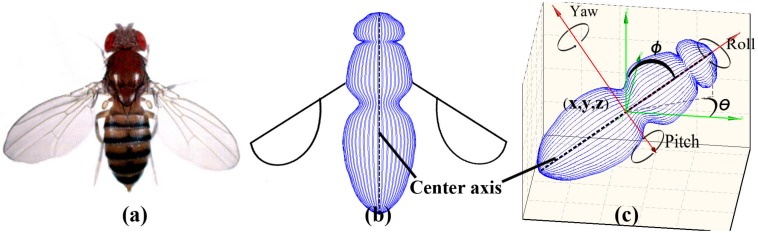
The fruit fly’s model.(a) The front image of an adult fruit fly. (b) The articulated model of the fruit fly. (c) A fruit fly locates at (x, y, z). Its orientation is defined by two angles (θ, ϕ) against the world’s coordinate system. θ is an angle from x-axis and ϕ is an angle from horizontal (the x-y plane). Combining the location (x, y, z) and orientation (θ, ϕ), it defines a directed line-segment in 3D space, the center-axis of the fruit fly.